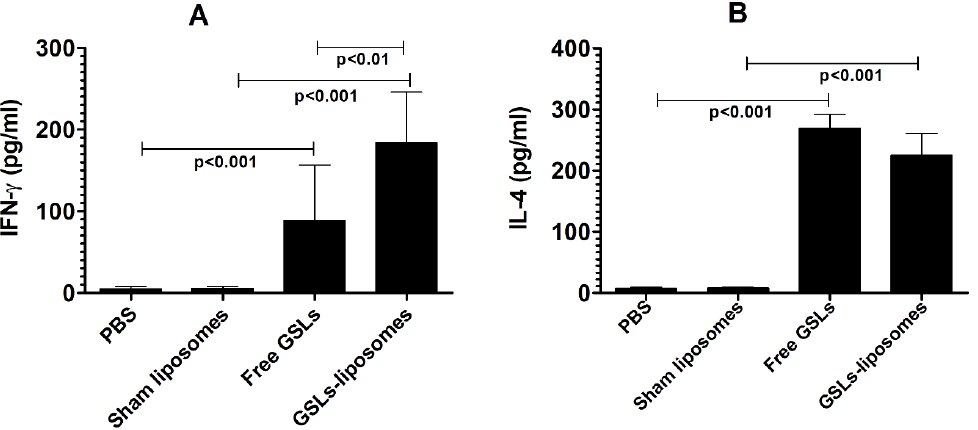
Figure 2. The levels of ( A ) IFN- γ and ( B ) IL-4 in the supernatant of splenocytes co-cultured with GSLs-liposomes. Free GSLs- or GSLs-liposomes-loaded BMDCs were co-cultured with the spleno- cytes for 48 h, and the culture supernatant was collected to analyze IFN- γ and IL -4. The data are expressed as mean ± SD of three values.